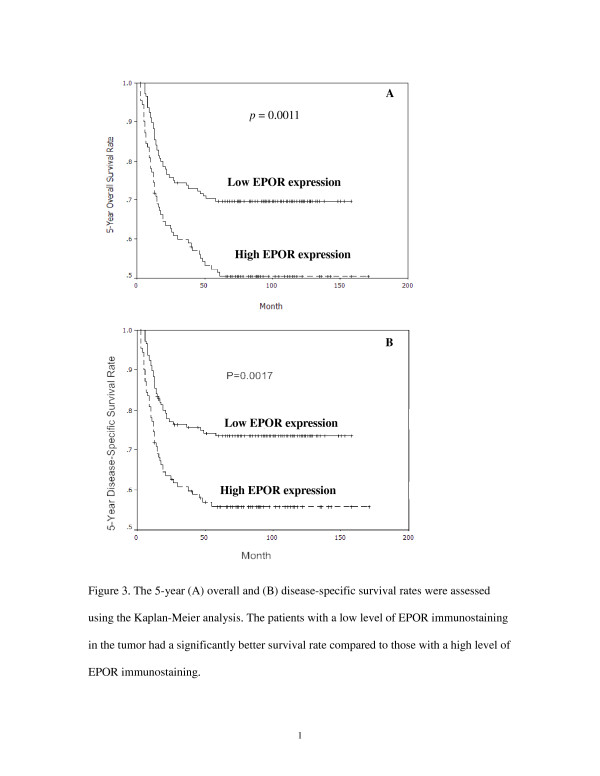
The 5-year (a) overall and (b) disease-specific survival rates were assessed using the Kaplan-Meier analysis. The patients with a low level of EPOR immunostaining in the tumor had a significantly better survival rate compared to those with a high level of EPOR immunostaining.